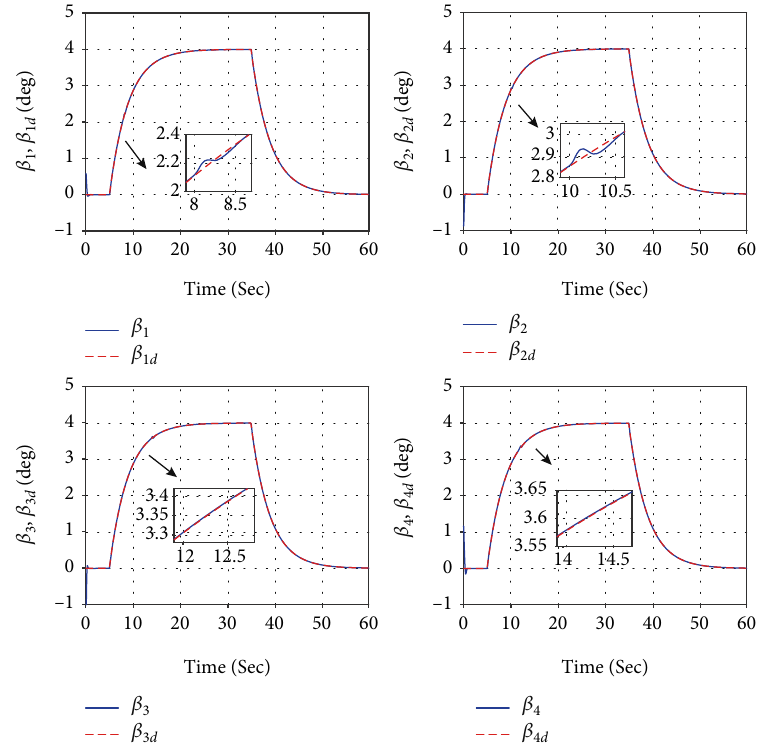
Figure 6: Sideslip angles β